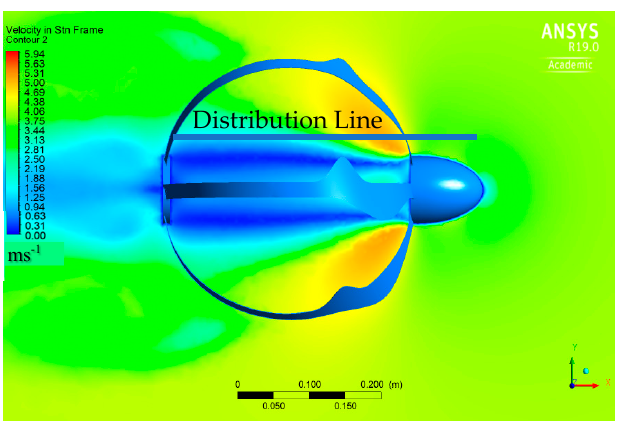
Figure 14. Velocity contours around six-bladed EBWT at 0.8 TSR and illustration line for pressure and velocity distribution.